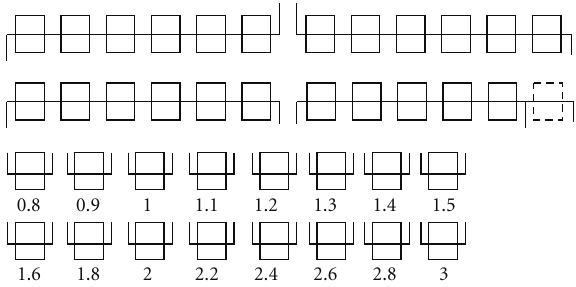
Figure 4: The makeup of module before